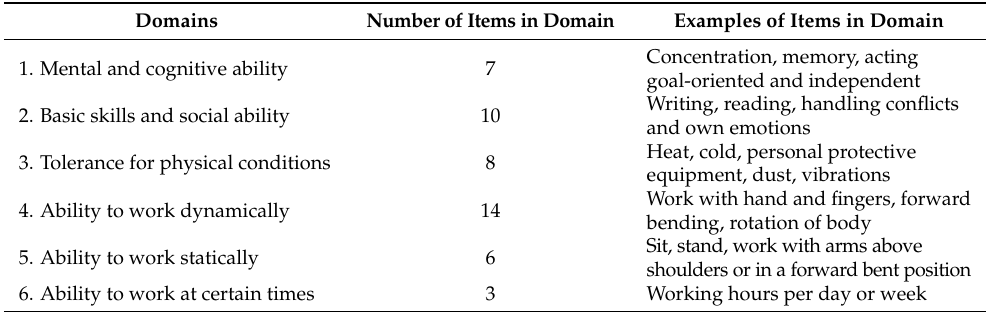
Table 1. A presentation of the six domains included in the DAP, the number of items in each domain, and examples of items